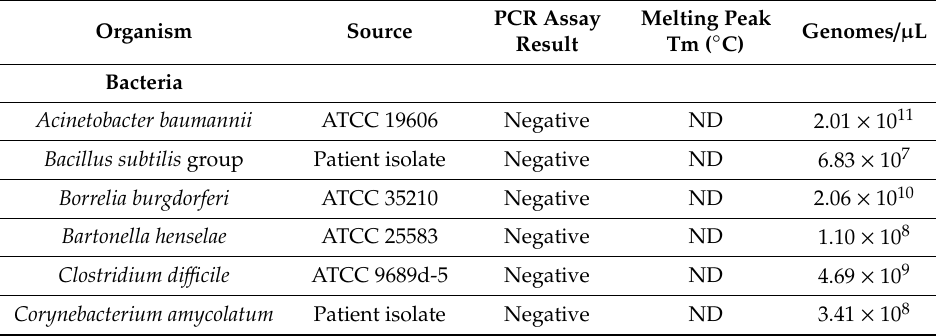
Table A4. Specificity panel of organisms tested by the PCR